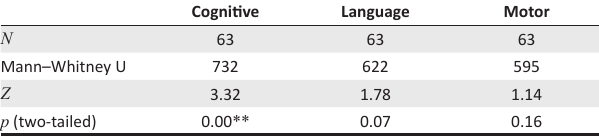
TABLE 2: Statistics a,b for subscale comparisons in the intervention group ( N = 29) before and after the intervention programme. Cognitive2 Cognitive1 Language2 Language1